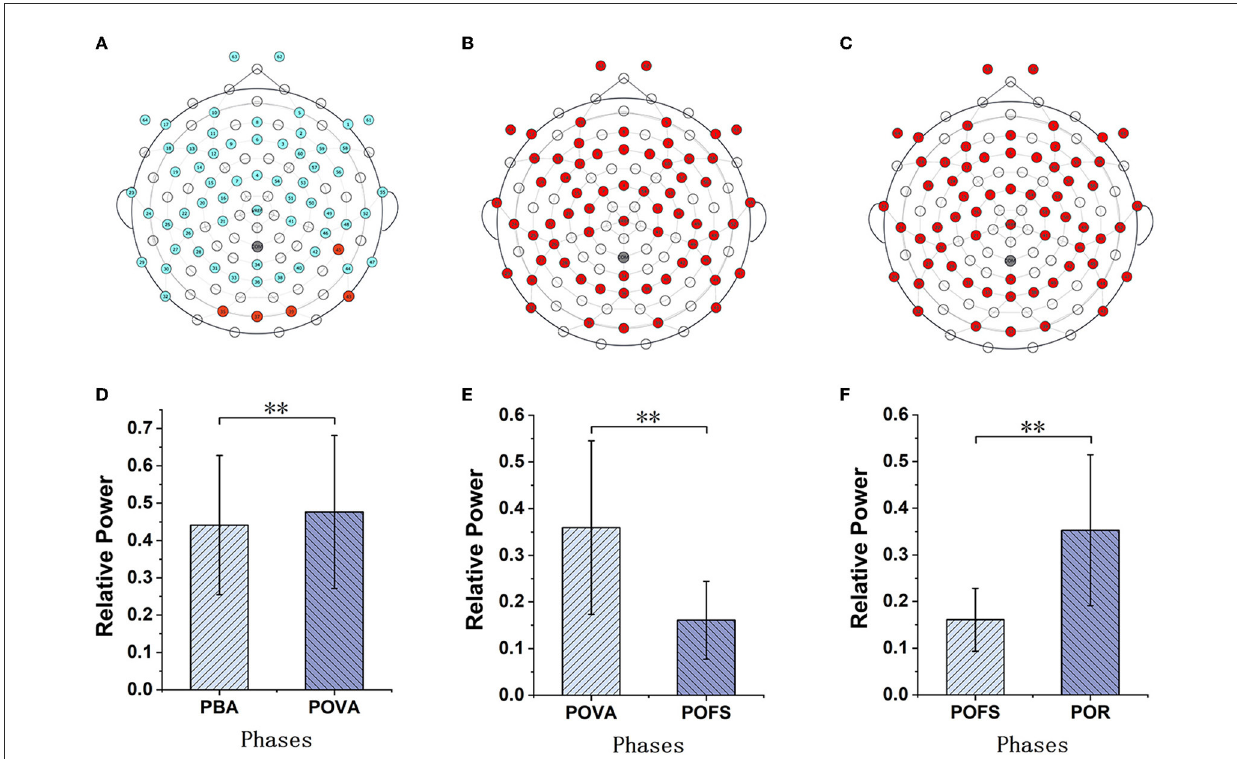
FIGURE4 The comparison of alpha power in different phases. (A–C) are the brain topography distributions of selected channels in the PBA and POVA comparison, POVA and POFS comparison, and POFS and POR comparison, respectively. In the brain topography, the red dots are channels with significant differences between the two comparisons, the blue dots are channels without significant differences, and the white dots are empty channels. Mean relative power changes according to the selected channels are shown in red in (A–C) for the PBA and POVA comparison, the POVA and POFS comparison, and the POFS and POR comparison are shown in (D–F) , respectively. ** p < 0.01.